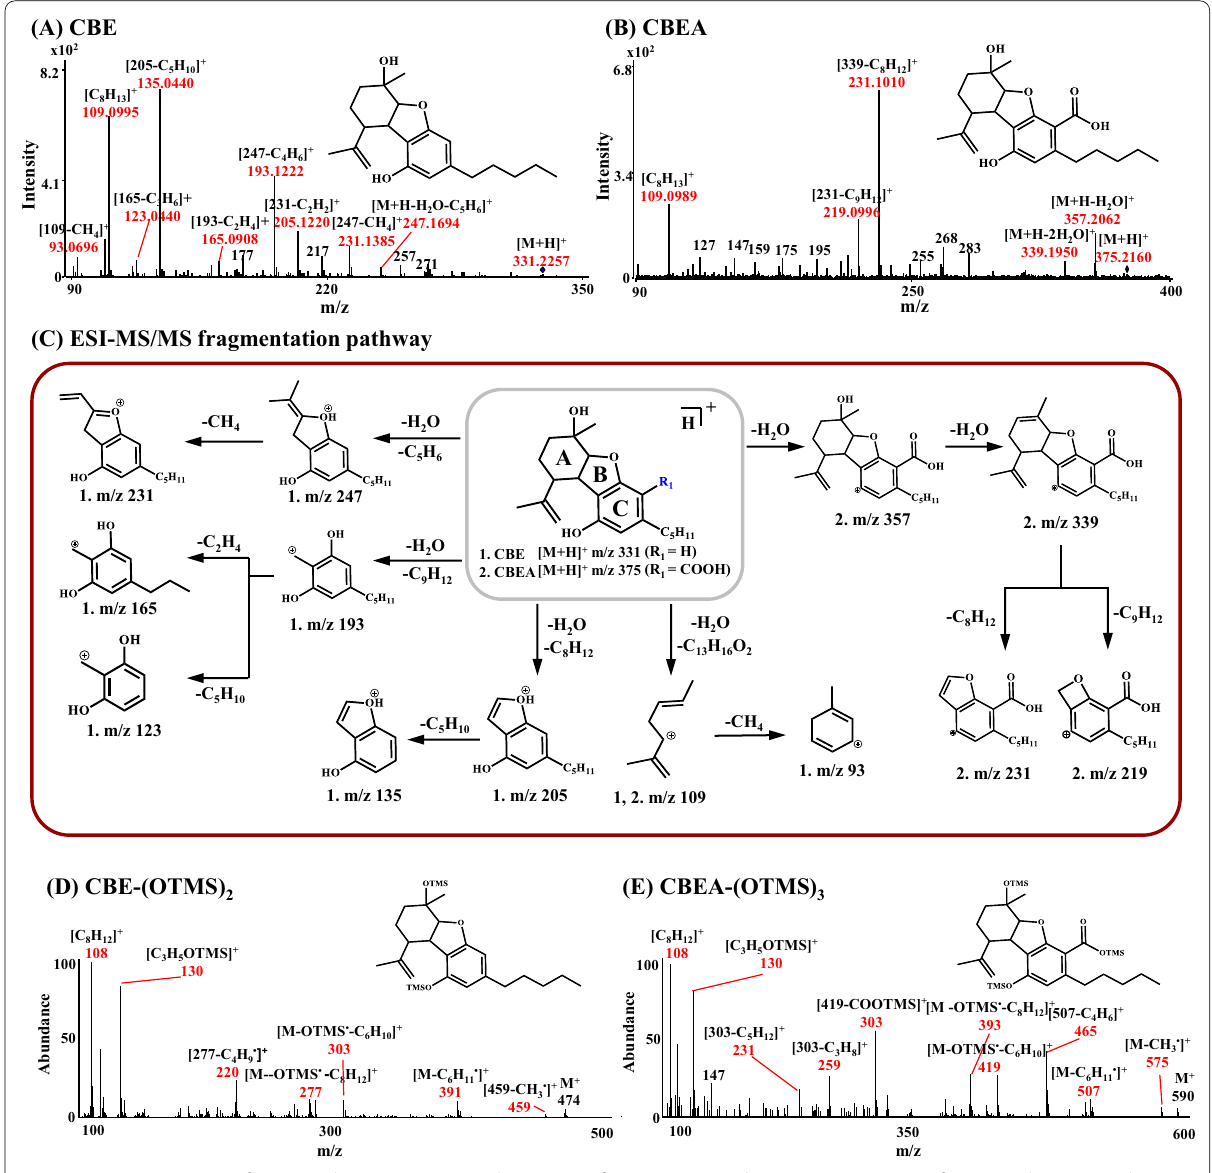
Fig. 4 ESI–MS/MS spectra of A CBE and B CBEA, C proposed ESI–MS/MS fragmentation pathways, EI mass spectra of D CBE and E CBEA, and F proposed EI mass fragmentation